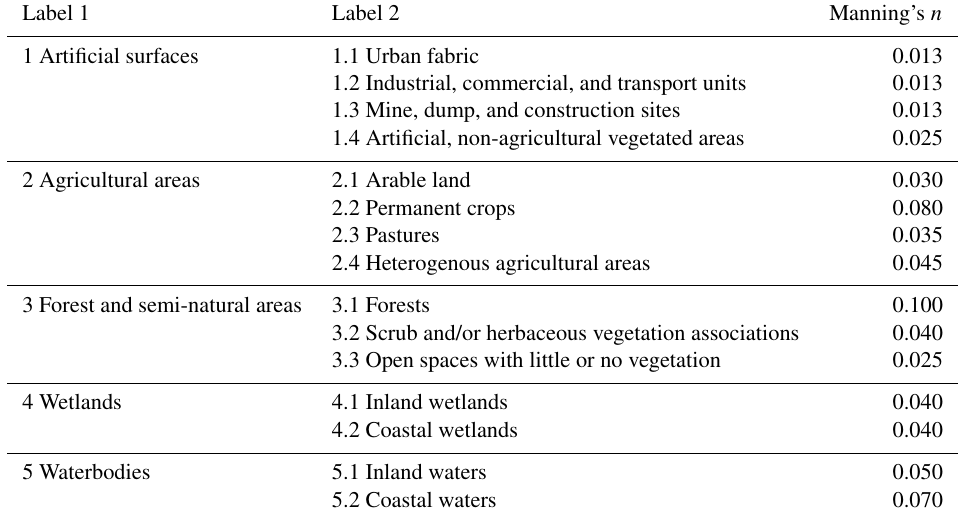
Table 2. Peak discharges of the streams for discharge of 10-year recurrence interval in the study area (Papaioannou et al., 2018). Label 1 Label